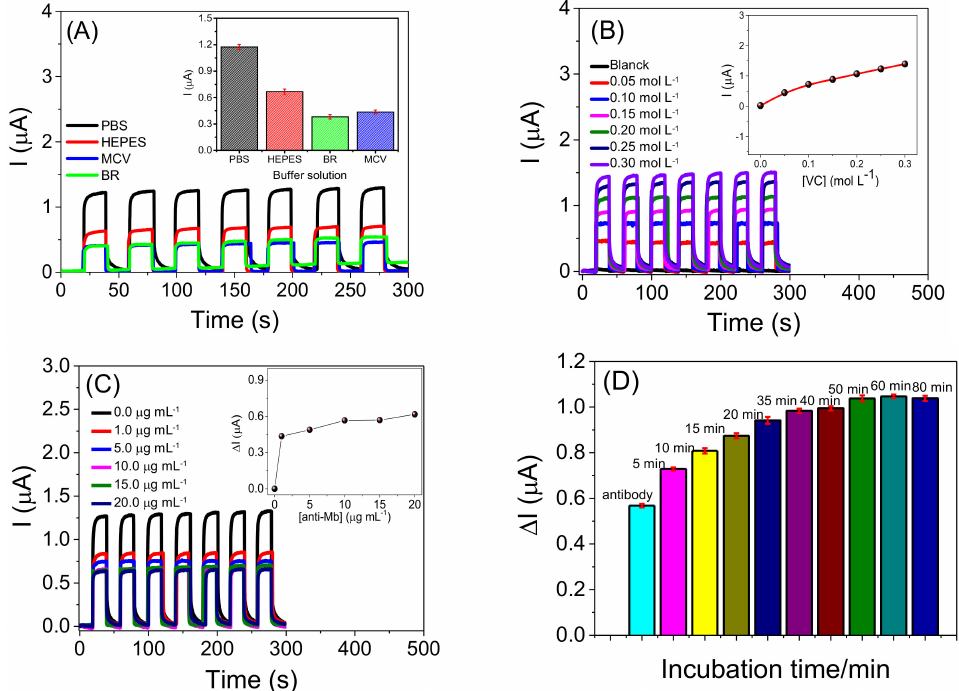
Figure 4. ( A ) Amperograms for the FTO modified with CdSeS/ZnSQDs/BTO in phosphate buffer solution (PBS); HEPES; Macllvain (MCV), and Britton-Robinson (BR), containing 0.20 mol L − 1 of VC. Insertion of Figure 4A: Plot of current vs. buffer solution; ( B ) Amperograms for the CdSeS/ZnSQDs/BTO/FTO platform containing different concentrations of VC. Insertion of Figure 4B: Plot of current vs. VC concentration; ( C ) Amperograms obtained for the anti- Mb/CdSeS/ZnSQDs/BTO/FTO immunosensor at employing different concentrations of anti- Mb. Insertion of Figure 4C Plot of current vs. concentration of anti-Mb; ( D ) Plot of the anti- Mb/CdSeS/ZnSQDs/BTO/FTO immunosensor response at different times of incubation with Mb. Experiments performed 0.10 mol L − 1 PBS, pH 7.4, containing 0.25 mol L − 1 of VC under an applied potential of 0